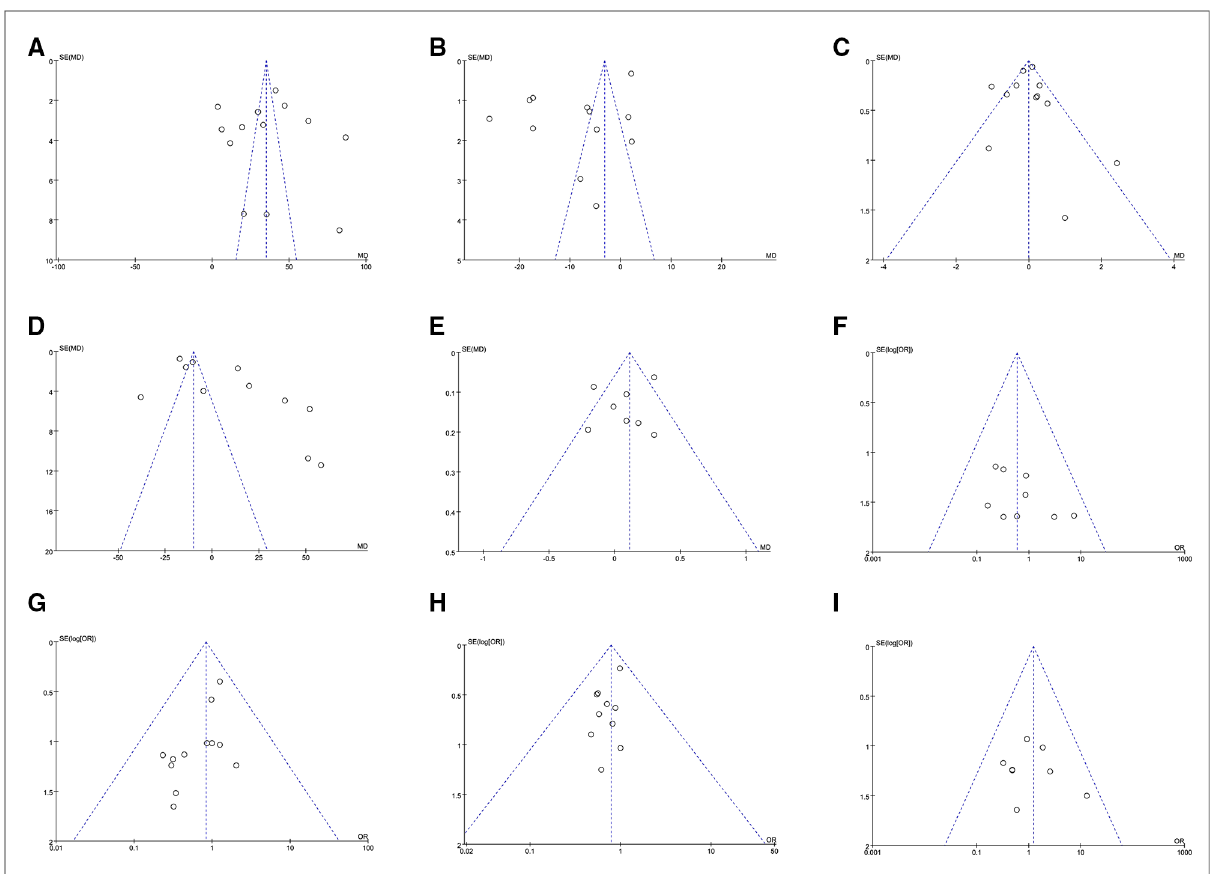
FIGURE 4 Funnel plot of all outcomes in all included studies. OR: odds ratio. ( A ) operative time; ( B ) intraoperative bleeding volume; ( C ) removed lymph node; ( D ) postoperative drainage volume; ( E ) length of postoperative hospital stay. ( F ) hoarseness; ( G ) hypocalcemia; ( H ) hematoma; ( I )